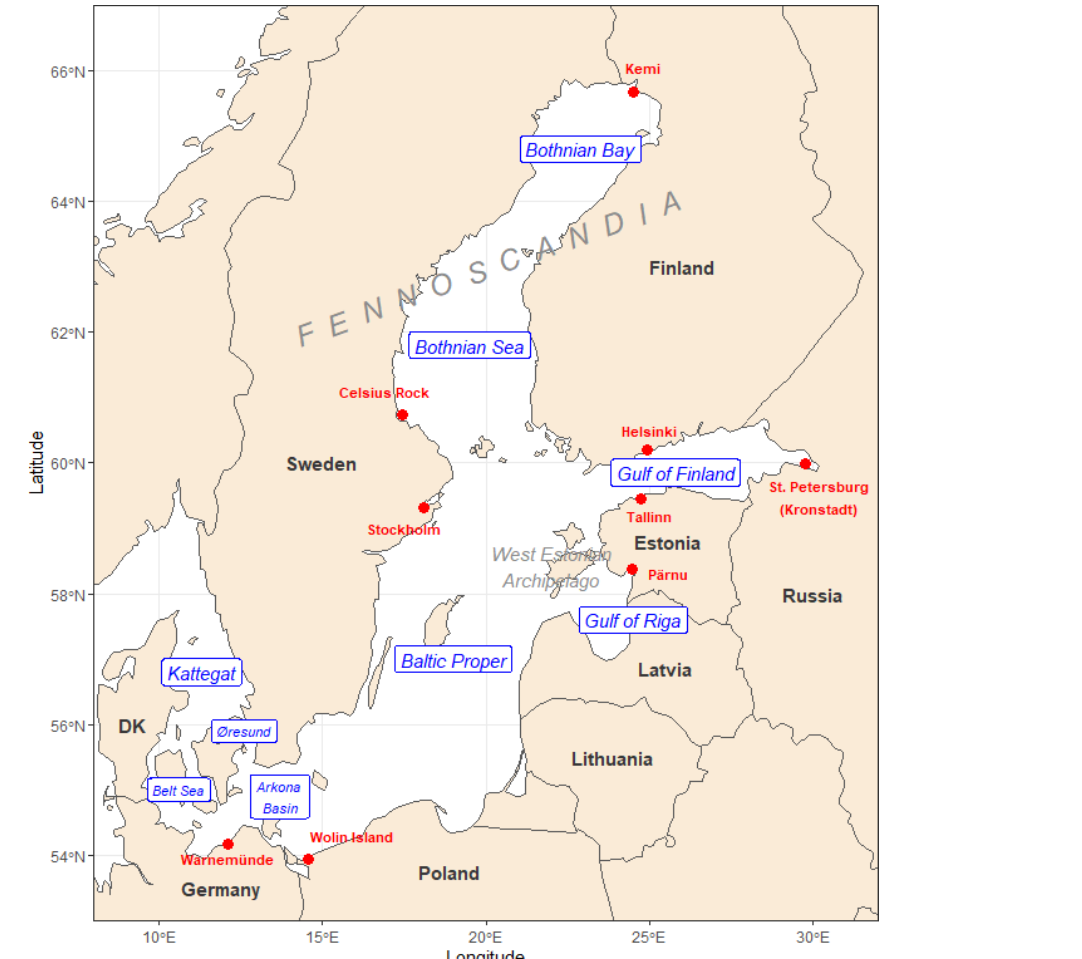
Figure 1. Map of the Baltic Sea, including the geographical names used in this paper. The Sound (Øresund) and the Belt Sea form the Danish straits. Bothnian Bay and the Bothnian Sea form the Gulf of